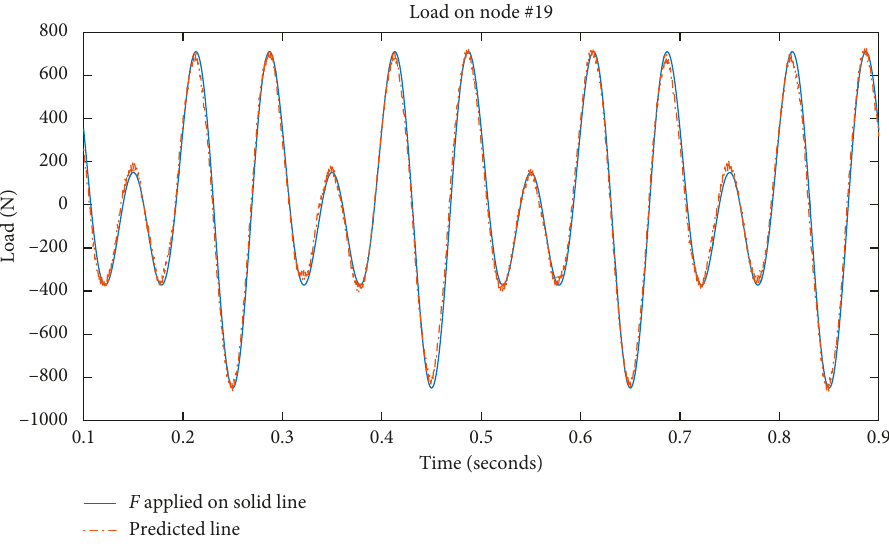
Figure 14: Applied and reconstructed load on node 19.